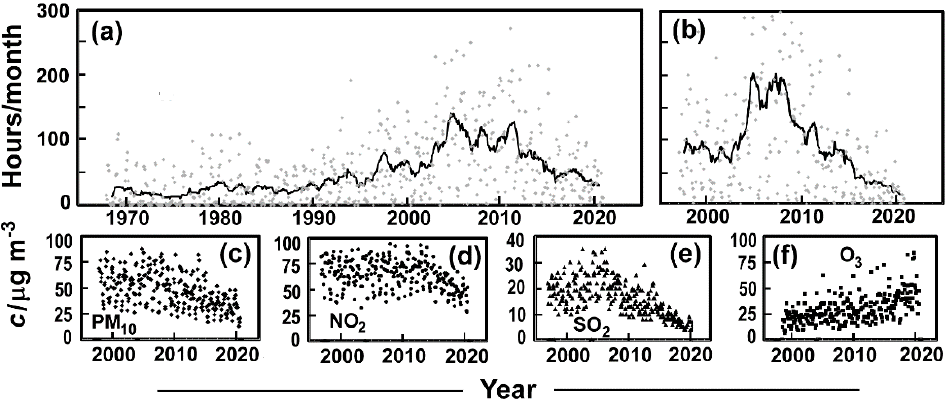
Figure 2. ( a ) Hours of low visibility each month ( n LV ) at HKO and ( b ) Hong Kong International Airport, along with the change in monthly average air pollutant concentrations at Sam Shui Po for ( c ) PM 10 , ( d ) NO 2 , ( e ) SO 2 , and ( f ) O 3 .